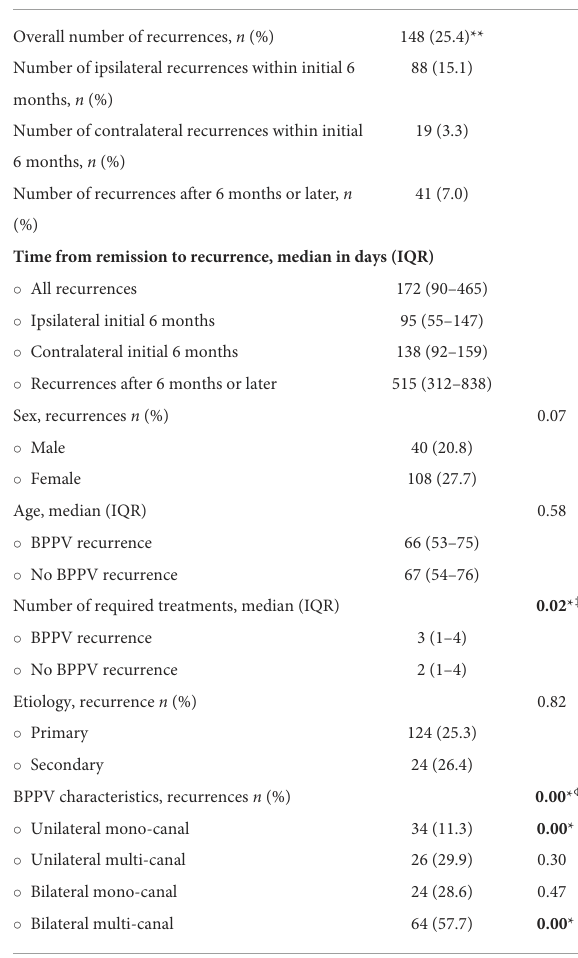
TABLE 5 Outcomes with patients requiring more than five treatments. TABLE 6 Recurrence of BPPV and risk factors associated with BPPV recurrences.